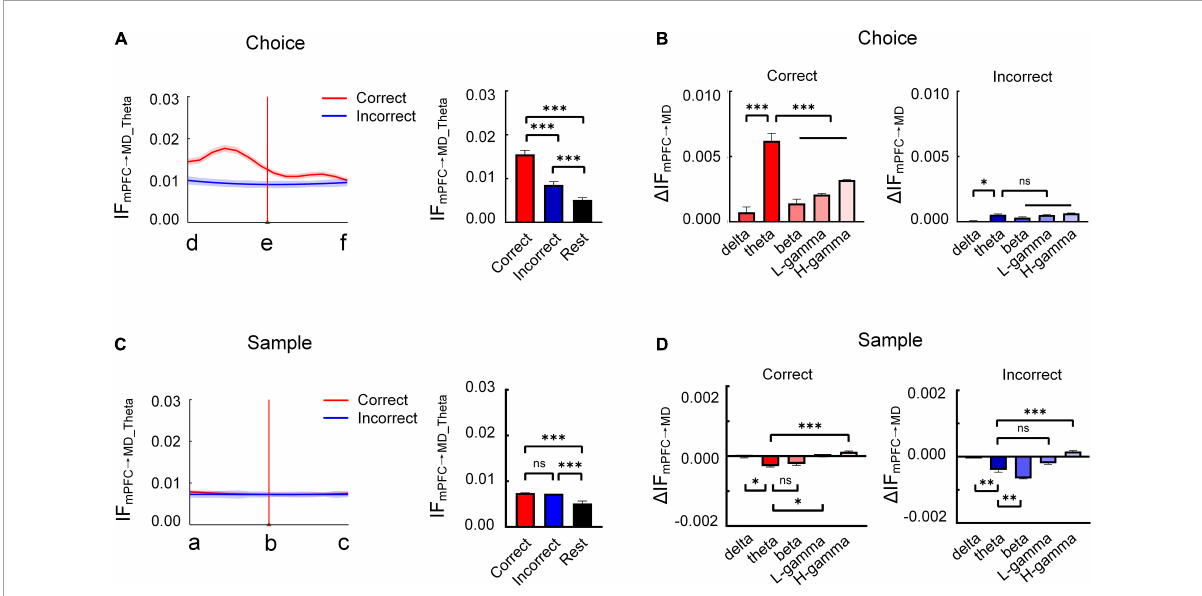
FIGURE3 Enhanced theta-band information flow from mPFC to MD correlates with the task epochs. (A) The average theta-band information flow from mPFC to MD during the choice phase across subjects ( n = 8 mice). (left) Changes in information flow over position [from start box (location “d”) to arrival at the reward port (location “f”)]. (Right) Comparison of theta-band information flow on correct, incorrect trials and rest stage (two-way ANOVA, F = 312.9, P < 0.001). (B) Theta-band information flow shows a remarkably increase on correct trials [ (cid:49) IF mPFC → MD is defined as peak of IF (the maximum of IF during the choice period: d → e) minus the initial value of IF (at location “d”)]. Correct: two-way AONVA, F = 43.31, P < 0.001; incorrect: two-way ANOVA, P > 0.05. (C) same as (A) , but for sample phase. The information flow showed no difference in the different trial types and the values on correct and incorrect trials were apparently higher than that at rest stage (two-way ANOVA, F = 274.8, P < 0.001). (D) Same as (B) , but for sample phase [ (cid:49) IF mPFC → MD is defined as peak of IF (the maximum of IF during the sample period: a → b) minus the initial value of IF (at location “a”)]. Correct: two-way AONVA, F = 12.13, P < 0.001; incorrect: two-way ANOVA, F = 44.29, P < 0.001. ∗ P < 0.05, ∗∗ P < 0.01, and ∗∗∗ P < 0.001. ns, not